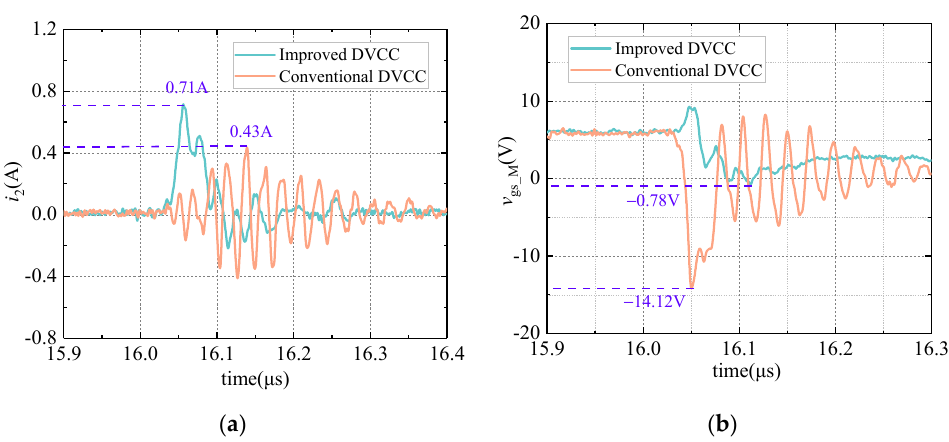
Figure 9. The current waveform flowing through V cc and the gate − source voltage waveform of M. ( a ) Current waveform; ( b ) voltage waveform.